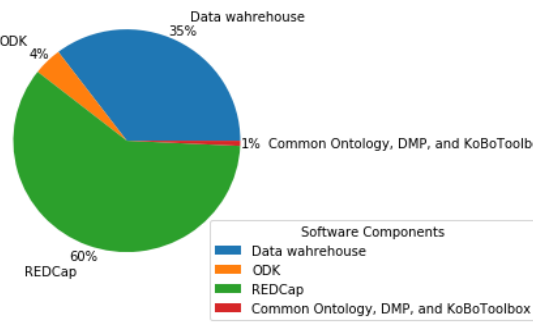
Figure 12. Percentage web hits of the various software